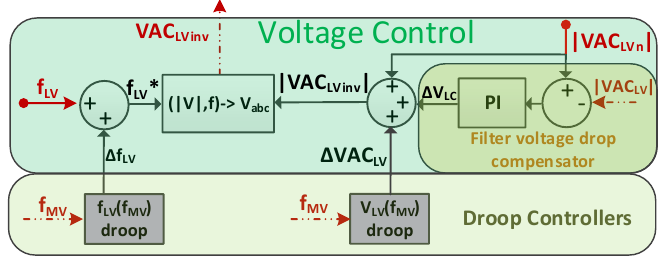
Figure 16. f LV ( f MV ) and V LV ( f MV ) droop controllers incorporated in the controller of the LV inverter (depicted in Figure